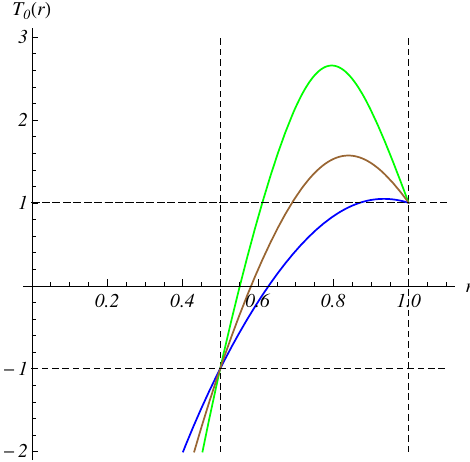
Figure 3. Three solutions of (11), (12) for R = 0.5.